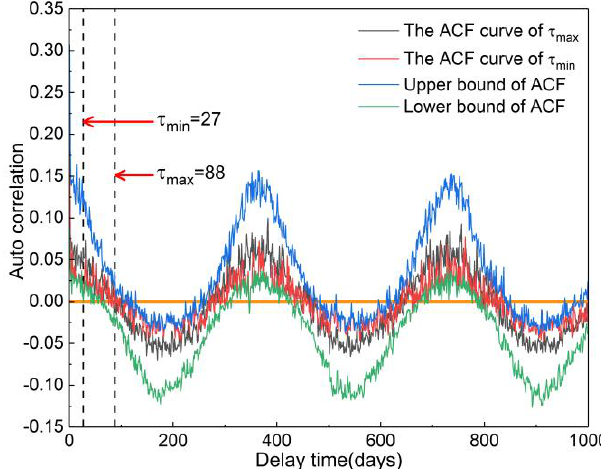
Figure 9. Autocorrelation function plot (lag length up to 1000 days) of daily precipitation for 36 meteorological stations.